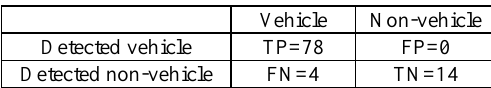
Table 2 The vehicle detection